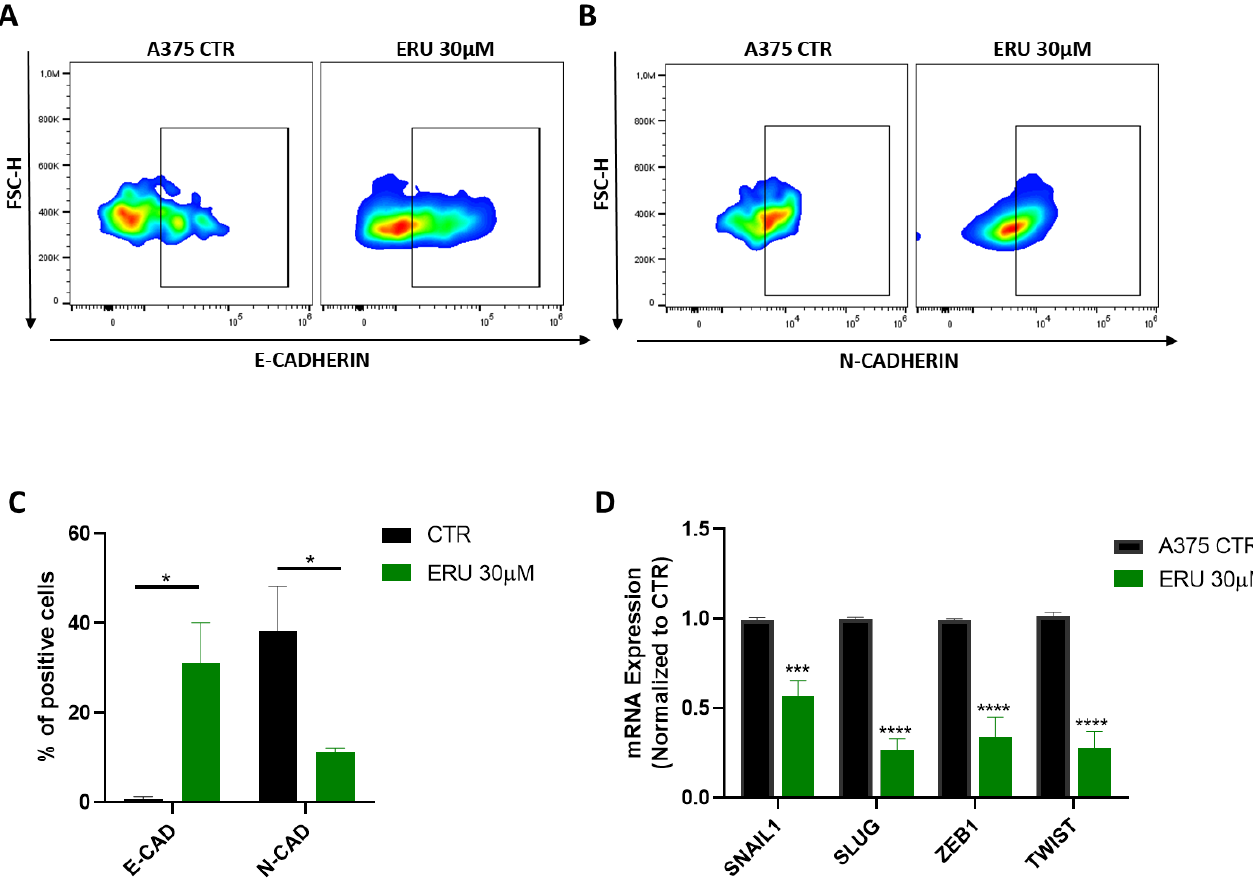
Figure 3. ERU modulated the expression of cadherins in human melanoma cells. ( A , B ) Representative example of flow cytometry analysis of A375-derived E-CAD and N-CAD upon treatment (green dot plot) or no treatment (black dot plot) with 30 μM ERU. ( C ) Frequency of Ki67 in A375 cells after treatment (green bar) or no treatment (black bar) with 30 μM ERU. ( D ) Expression of SNAIL1, SLUG, ZEB-1 and TWIST assessed with qPCR in A375 cells upon 6 h of treatment (green bar) or no treatment (black bar) with 30 μM ERU. Data were shown as mean ± SEM of at least three independent experiments (* p < 0.05, *** p < 0.001 and **** p < 0.0001 vs. A375 CTRL).